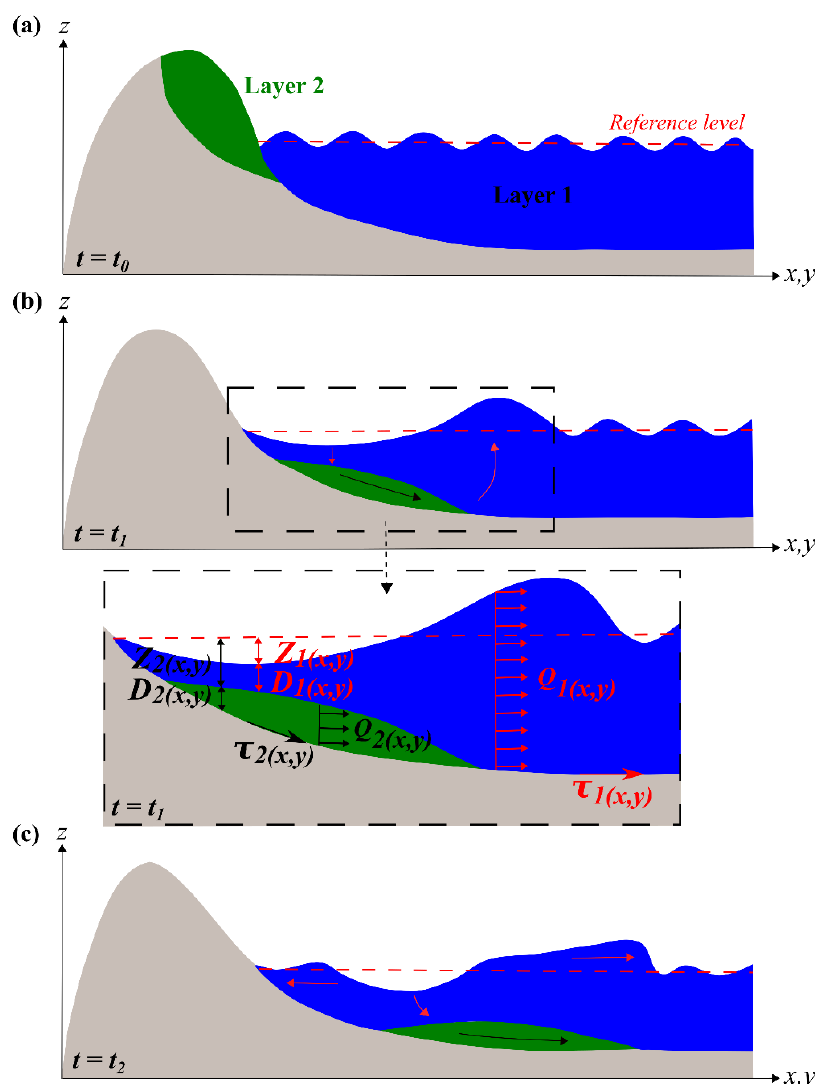
Figure A1. Two-layer modelling of a subaerial and submarine landslide (from the original sketch of Pakoksung et al., 2019): (a) pre-failure, (b) generation of negative and positive waves due to the landslide, and (c) landslide in progress and wave